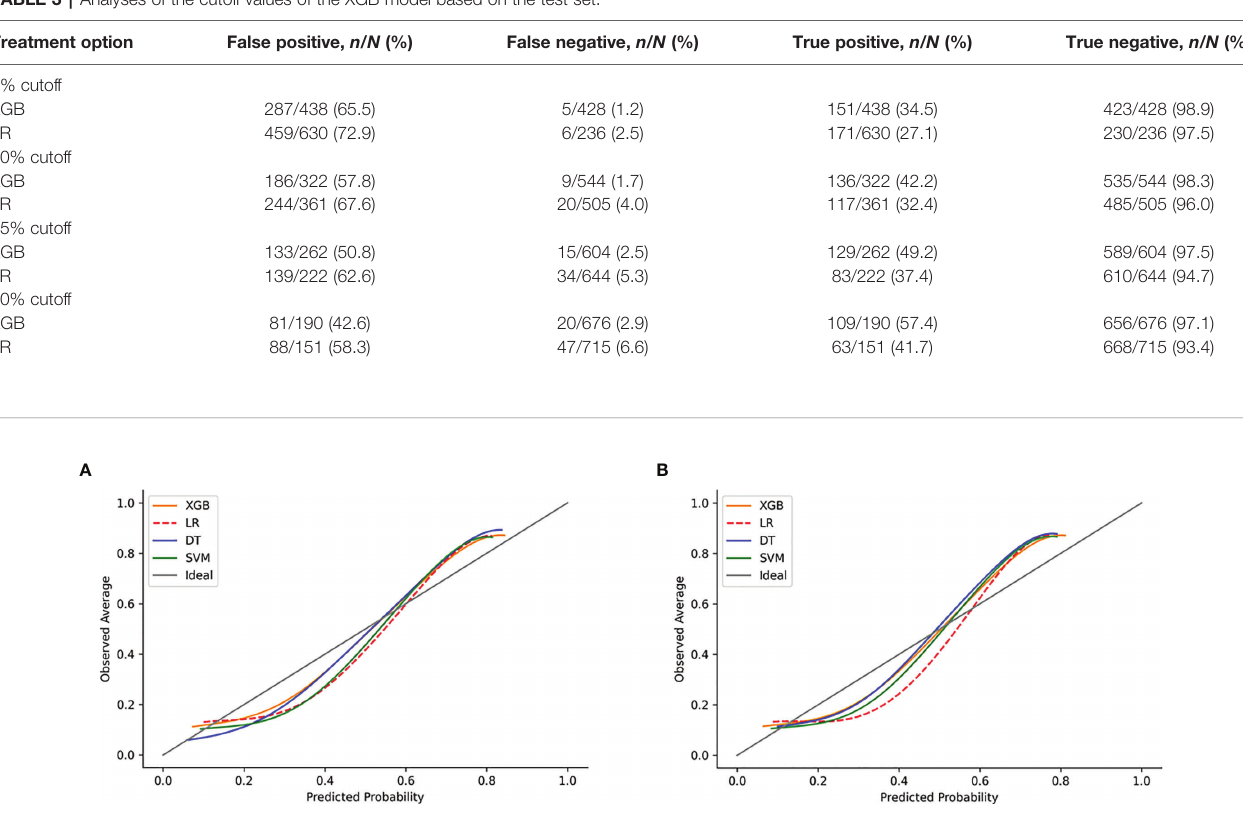
FIGURE 6 | Examples of calibration plots for predicting LNI with various models: XGB, SVM, DT, and LR. (A) The training set, and (B) the test set. The 45° straight line on each graph represents the perfect match between the observed ( y -axis) and predicted ( x -axis) survival probabilities. A closer distance between two curves indicates greater accuracy.